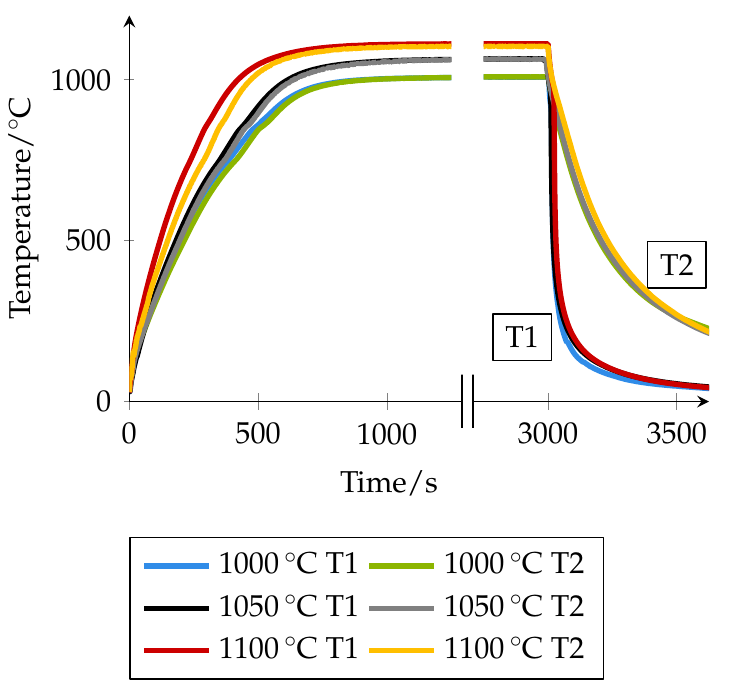
Figure 11. Experimental time-temperature sequences during the Jominy end quench test for different austenitizing temperatures.